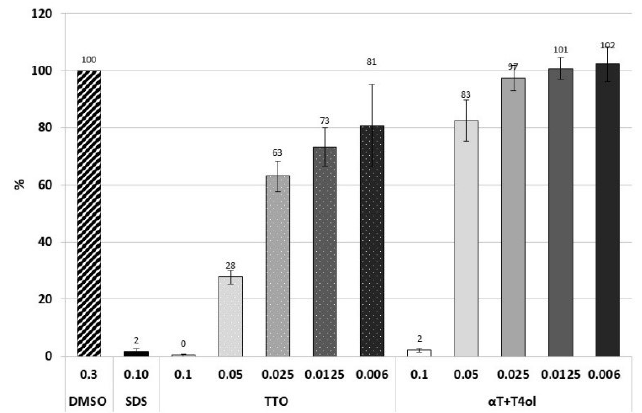
Figure 3. In vitro cytotoxicity of Synterpicine™ versus TTO. Survival percent of TTO and Synterpicine™ ( α T+T4ol) on human foreskin fibroblasts were reported. Samples were prepared in 0.30% DMSO. Concentrations ranged from 0.1% to 0.006% (v:v). SDS 0.10% was used as a positive control of cellular cytotoxicity. DMSO 0.3% alone was used as a negative control. The experiment was performed three times in triplicates on different days.